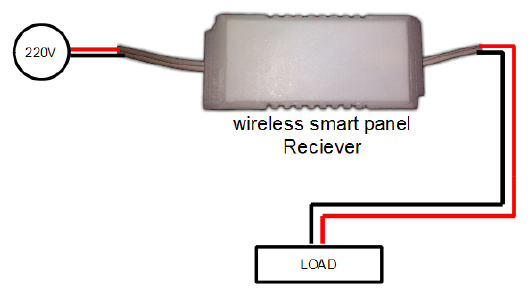
Figure 5. Remote control testing circuit